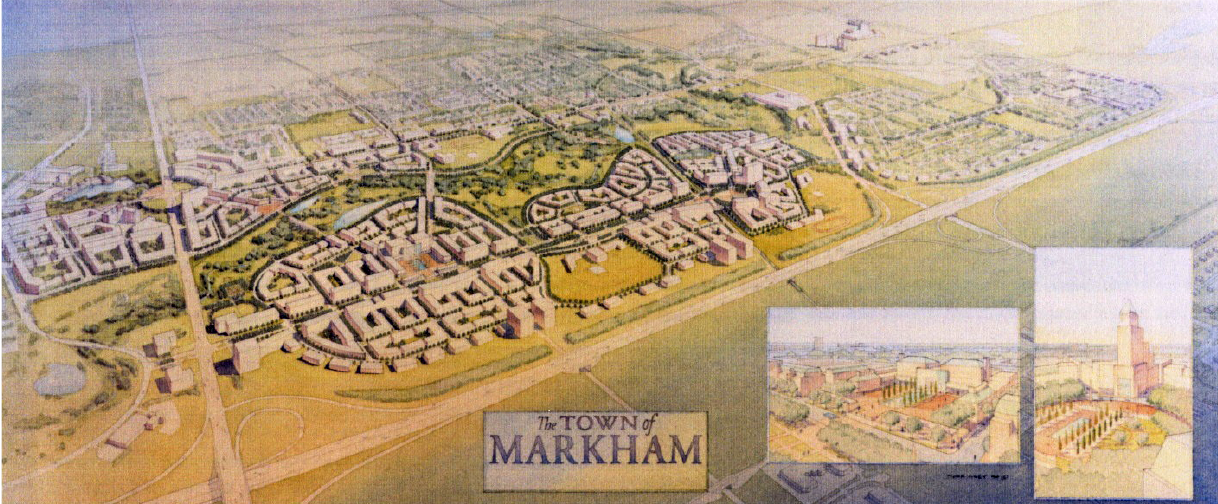
Figure 3. New urbanist vision for Markham Centre produced by DPZ and NORR Group. Source: Courtesy of City of Markham.